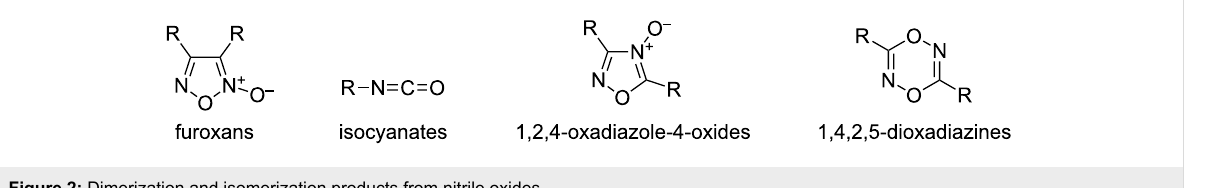
Figure 2: Dimerization and isomerization products from nitrile oxides.